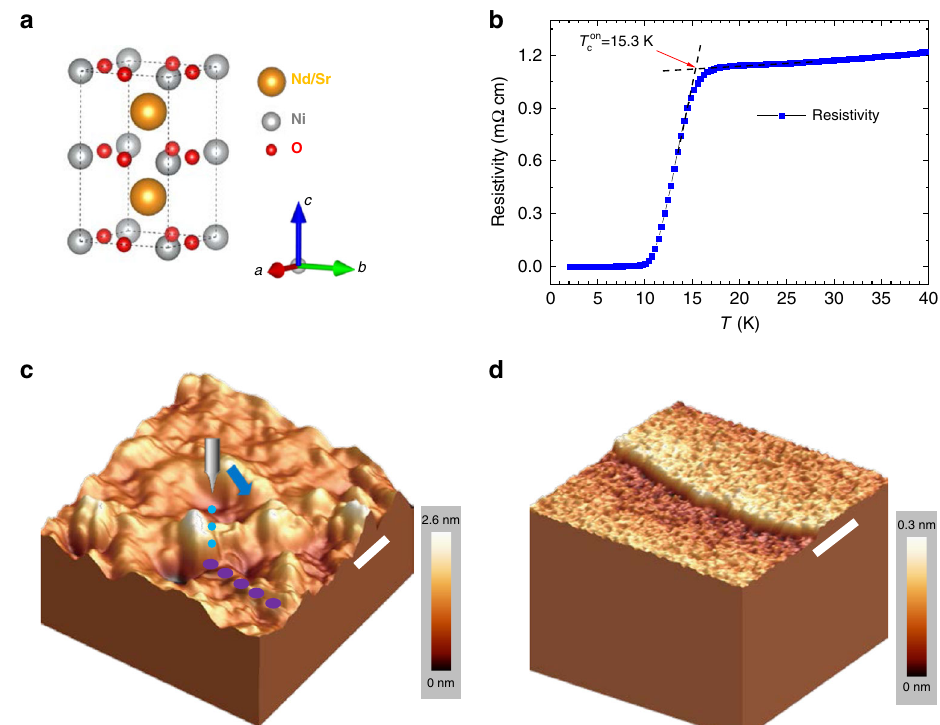
Fig. 1 Resistivity and topographic image of Nd 1-x Sr x NiO 2 fi lms. a Schematic plot of the atomic structure of Nd 1-x Sr x NiO 2 . b Temperature dependence of resistivity measured at zero magnetic fi eld. The onset transition temperature is about 15.3 K, and zero resistivity is achieved at about 9.1 K. c 3D illustration of the topographic image after soft-chemistry method, one can see the surface roughness about 1 – 2 nm. Scale bar = 5 nm. d 3D illustration of the topographic image after a long time vacuum annealing. The roughness becomes much smaller. We can see a clear step with the height about 0.17 nm, being consistent with one half of the unit cell height. Scale bar = 15 nm. Setting condition for c is V bias = -5.5 V, I t = 20 pA and for d is V bias = 0.57 V, I = 50 t